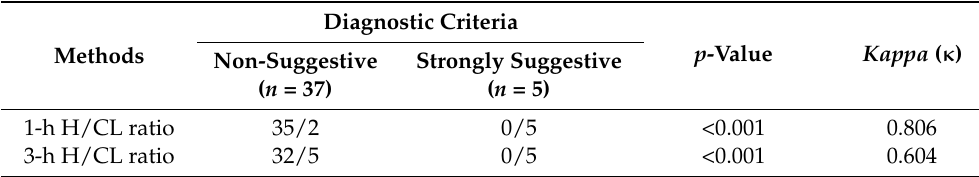
Table 2. Comparison of classification results between diagnostic criteria and various interpretation approaches for 99m Tc-PYP